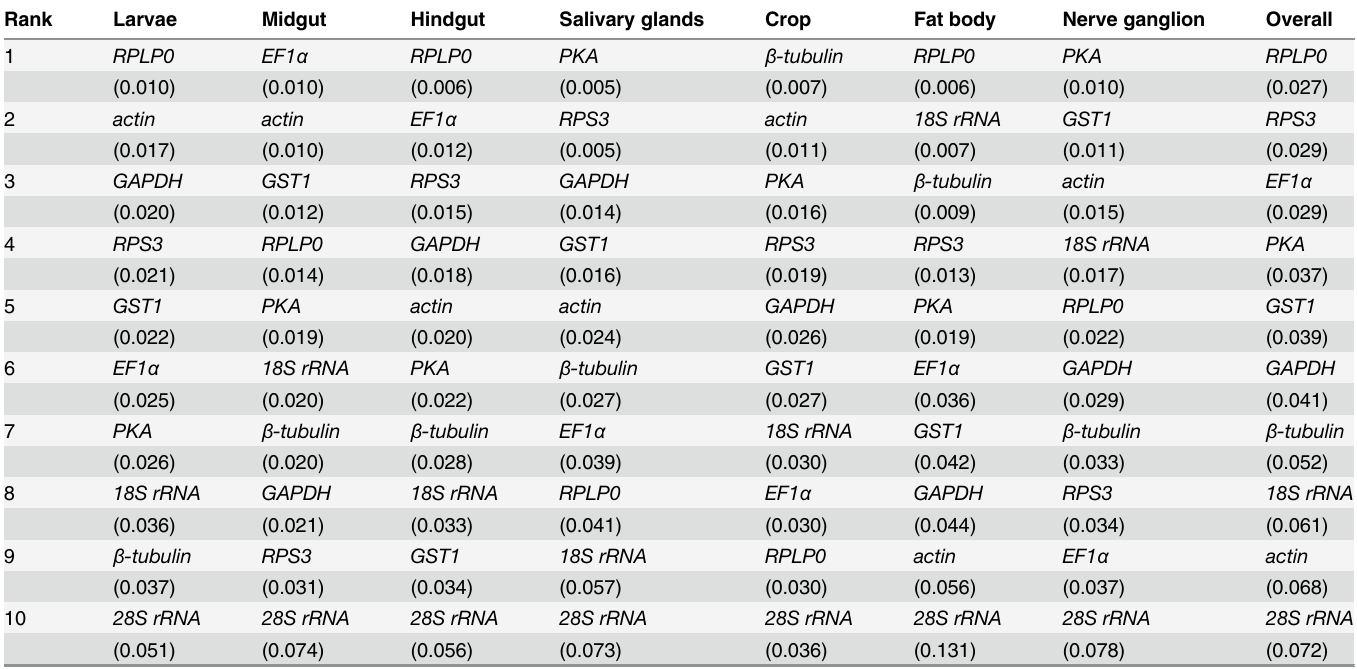
Table 2. Normfinder ranking of the stability values of candidate reference